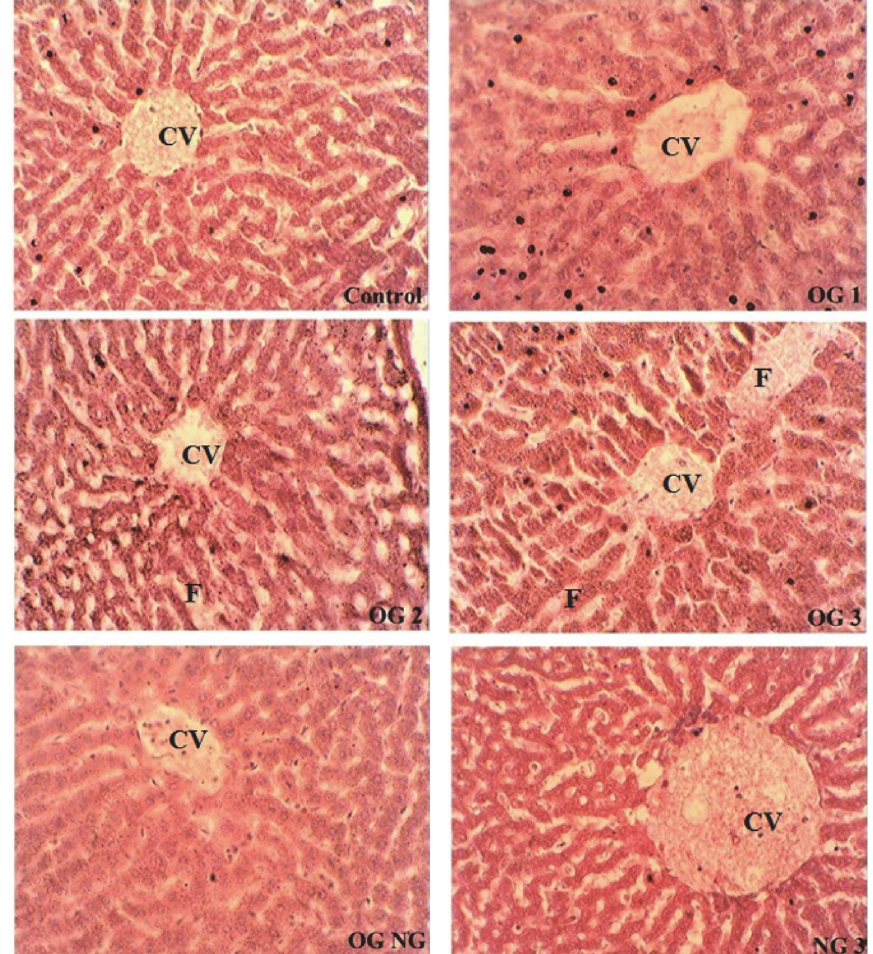
Figure 1: Effects of coadministration of unoxidized desi ghee with oxidized ghee on the liver structure of rabbits. Liver micrographs at × 40; control, OG1 (oxidized ghee 1g/kg), OG2 (oxidized ghee 2 g/kg), OG3 (oxidized ghee 3g/kg), OGNG (oxidized ghee 3g/kg + normal ghee 3 g/kg), and NG3 (normal ghee 3g/kg body weight). CV and F represent central vein and fats